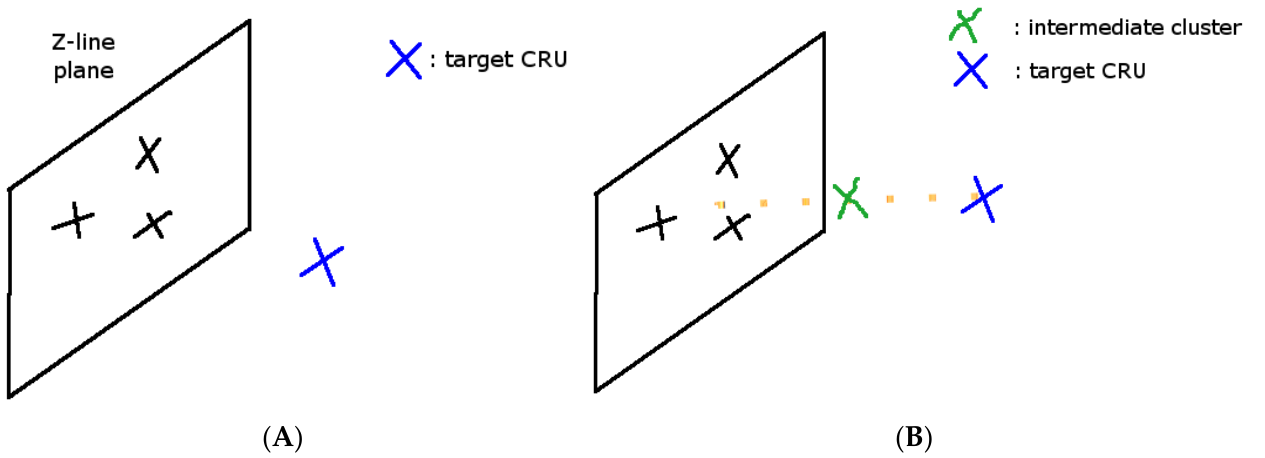
Figure 9. (A) Simulation geometry to study spark-induced waves (X = CRU location). Black X = the activated CRU, Blue X = the CRU to be activated by diffusing Ca 2+ . ( B ) The proposed simulation geometry with an intermediate cluster (Green X = intermediate RyR2 cluster).